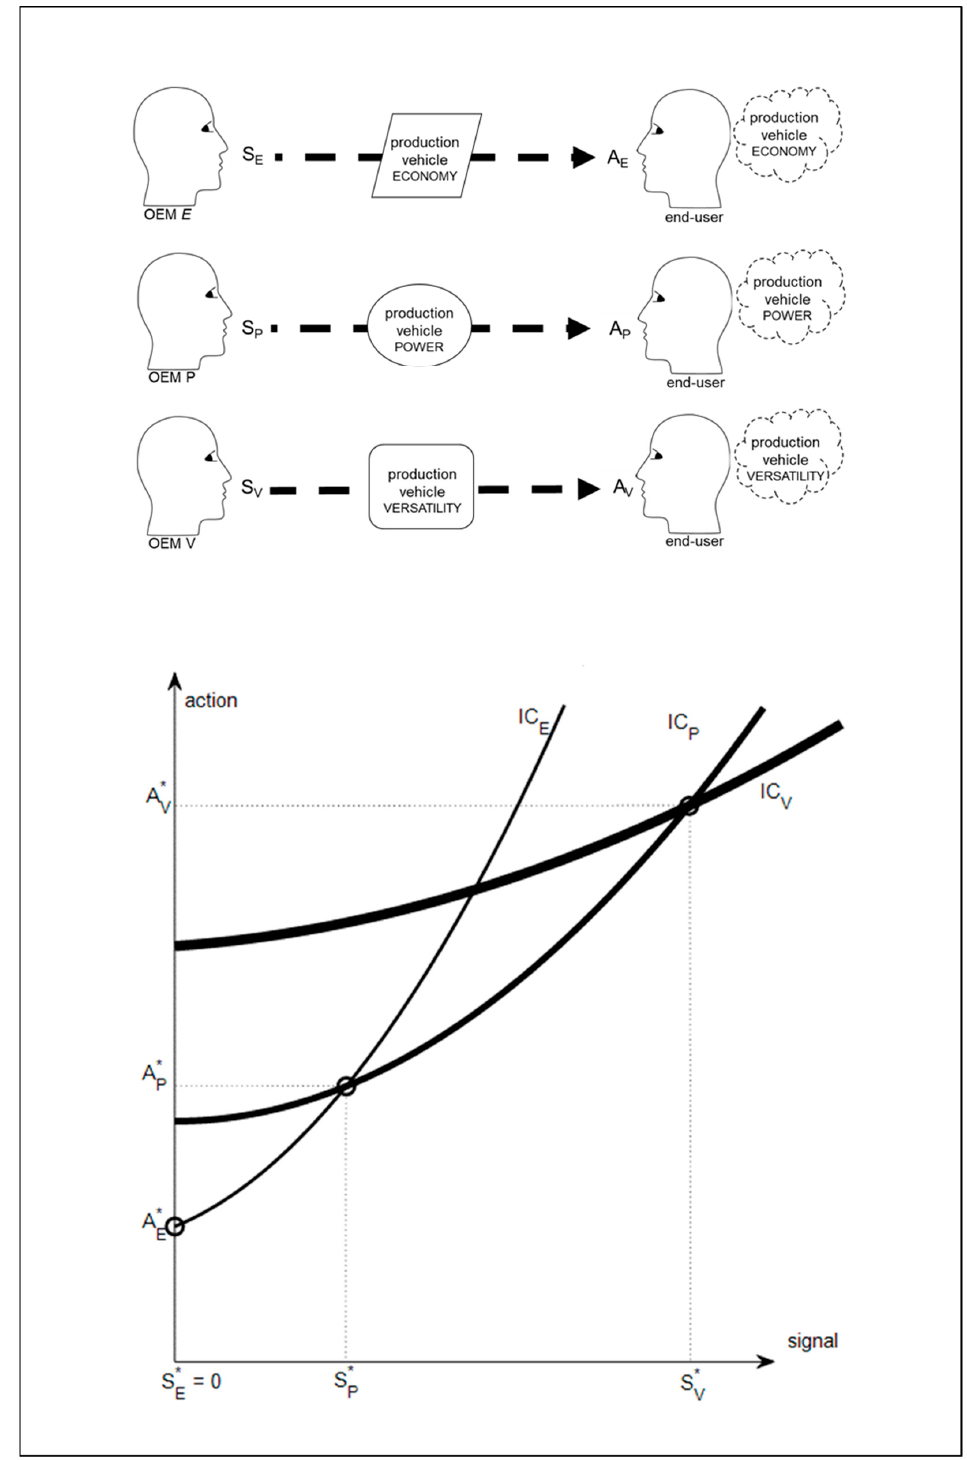
Figure 4. Generative synchronicity in an oligopoly. Three OEMs, E, P, and V, signal different fitness offers to end-users through primarily emphasizing the economy (E) or the power (P) or the versatility (V) of their production vehicles in accordance with the preferences of end-users.